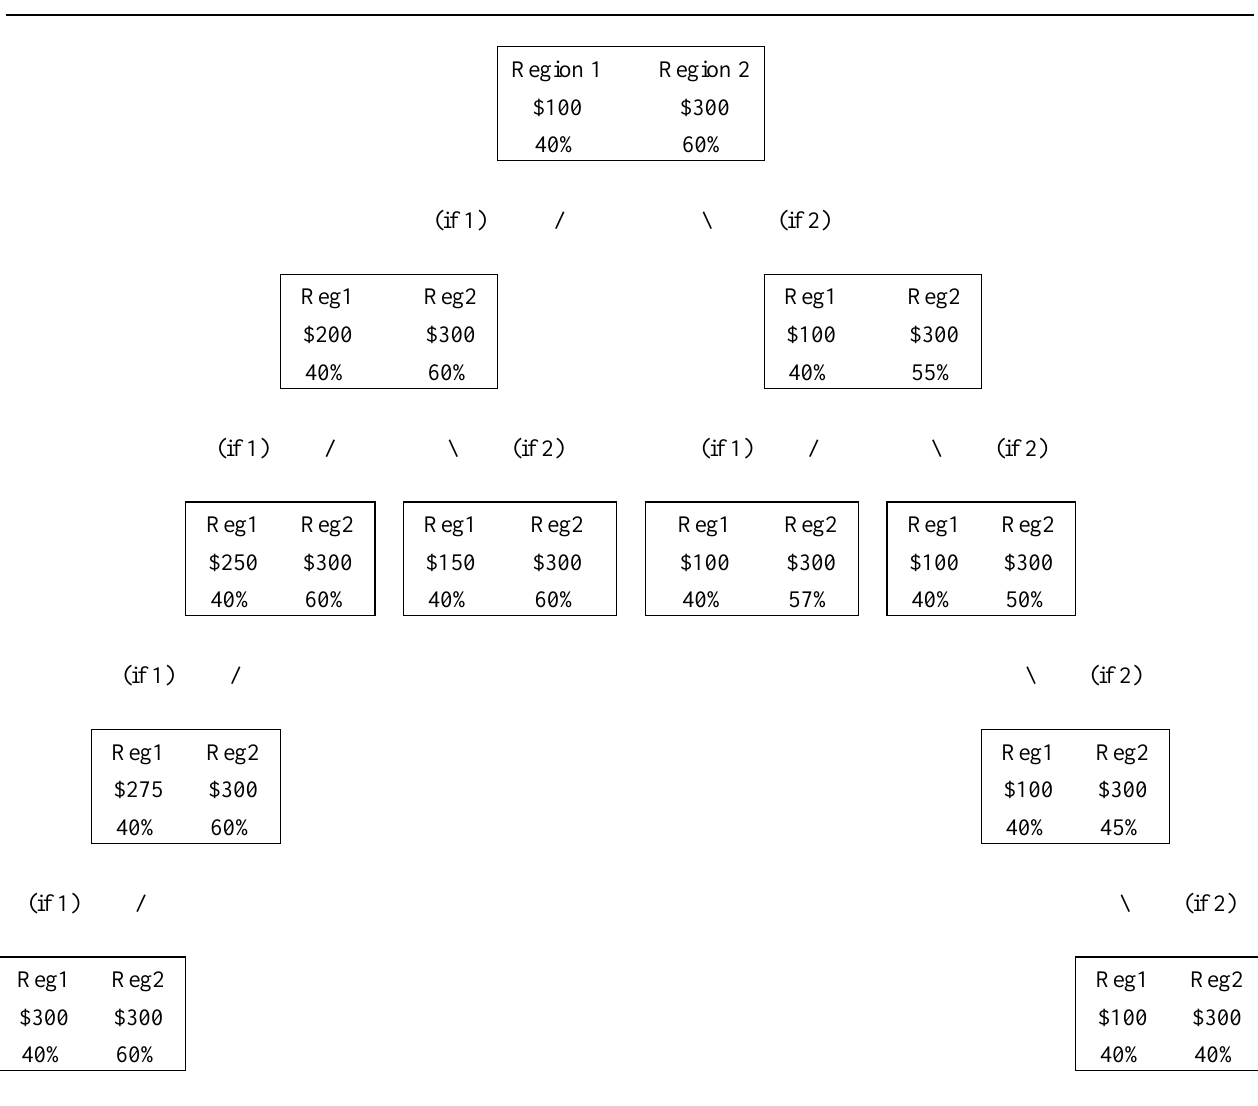
Figure 3. Survey decision